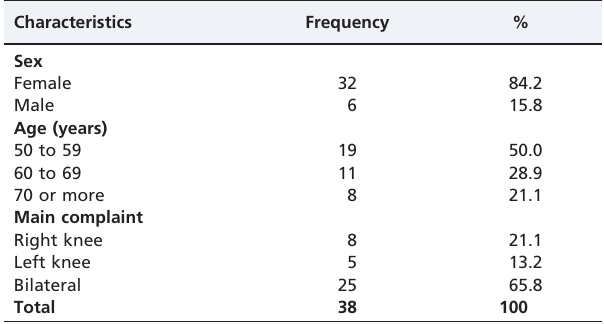
Table 1 - Demographic and clinical characteristics of patients with osteoarthritis of the knee submitted to